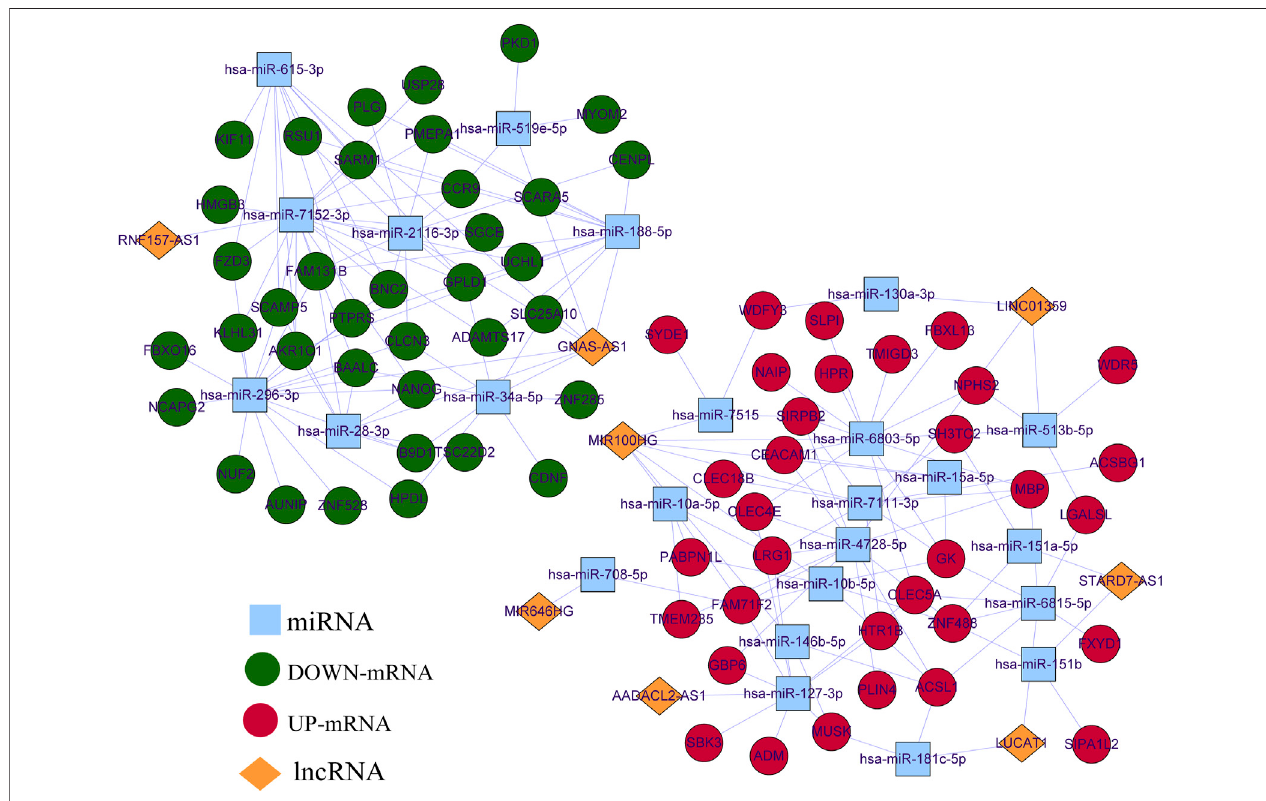
FIGURE3| CeRNA networkofOS-related DE-lncRNAs,DE-miRNA,and DE-mRNA.Redcirclenodes representup-regulated expression ofmRNAs.Greencircle nodes represent down-regulated expression of mRNAs. Yellow rhombus nodes represent upregulated expression of lncRNAs. Purple rhombus nodes represent downregulated expression of lncRNAs.Sky-blue square nodes represent DE-miRNAs.